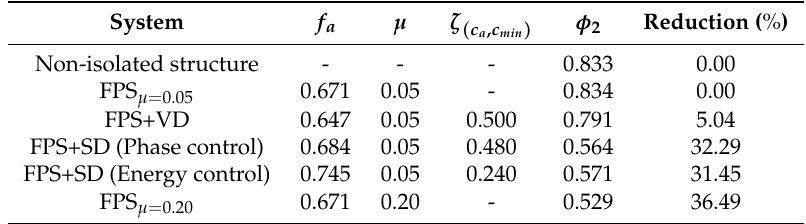
Table 2. Optimum parameters for the isolator configurations